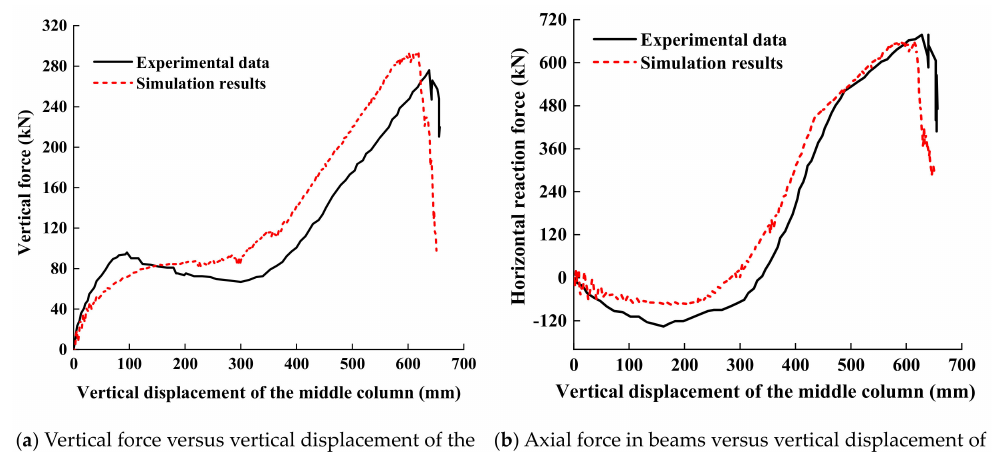
Figure 8. Boundary constraints of the composite frame model.